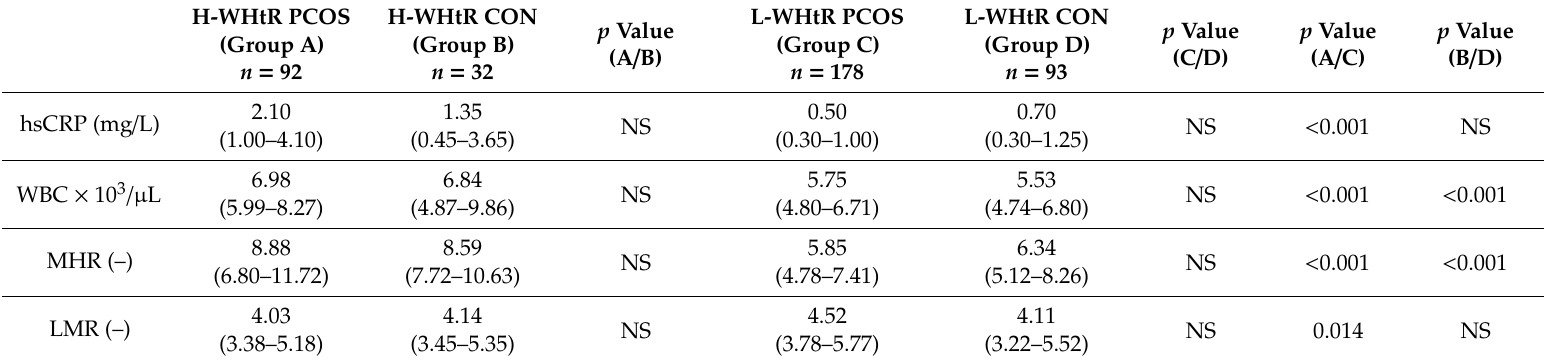
Table 5. Inflammatory parameters for PCOS and CON